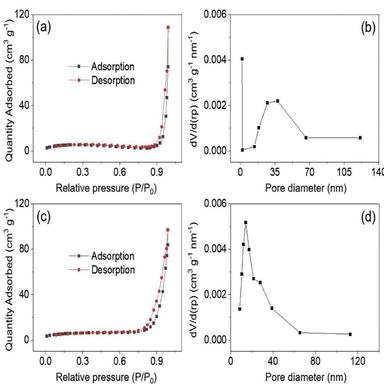
The N2 adsorption-desorption isotherm curves of (a) MCO-NWs and (c) MCO-MCs, and the plots of pore size for (b) MCO-NWs and (d) MCO-MCs.